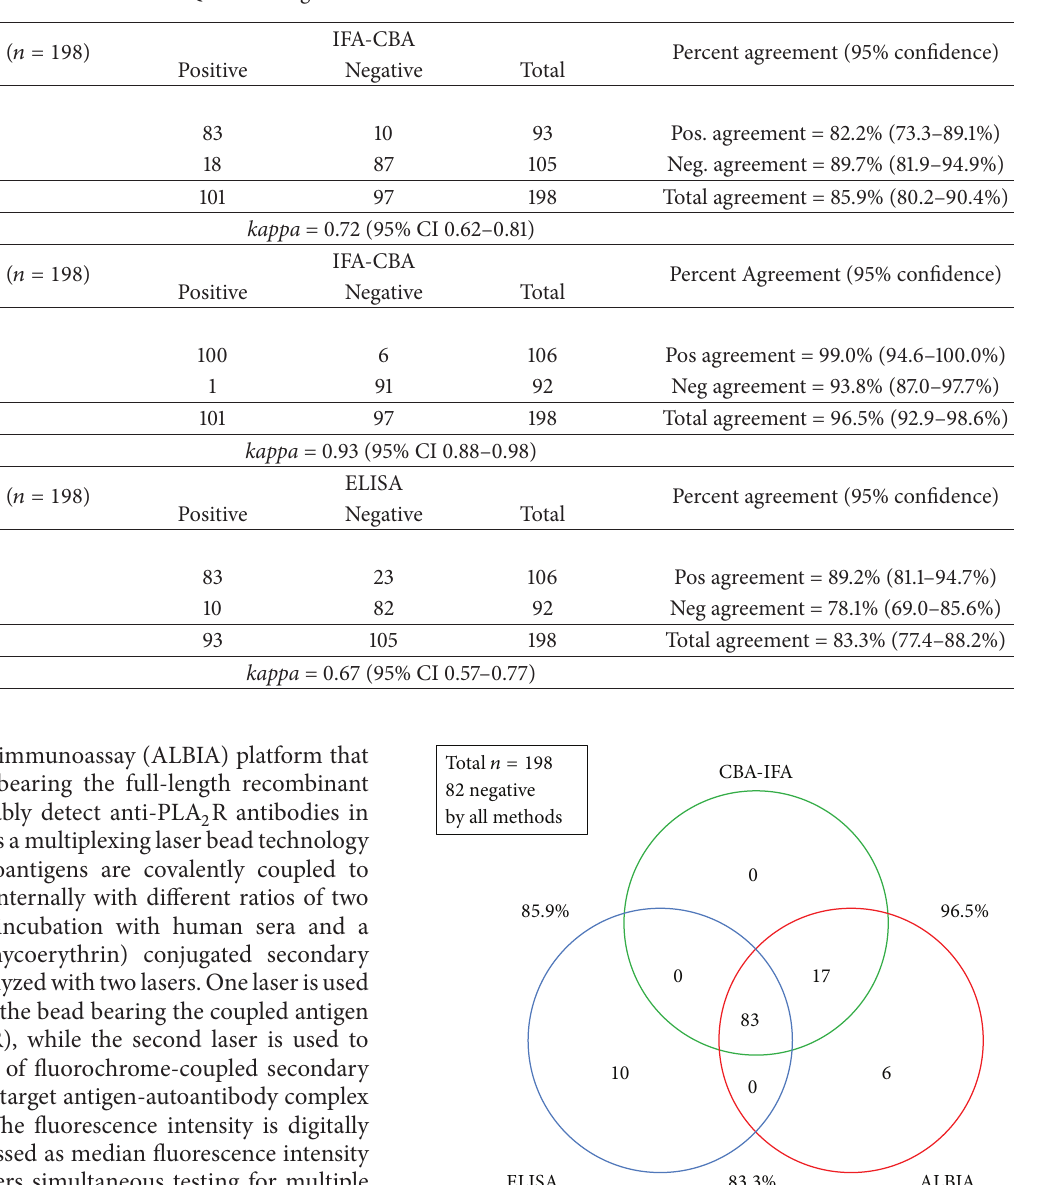
Table 1: Qualitative agreements between the different methods.